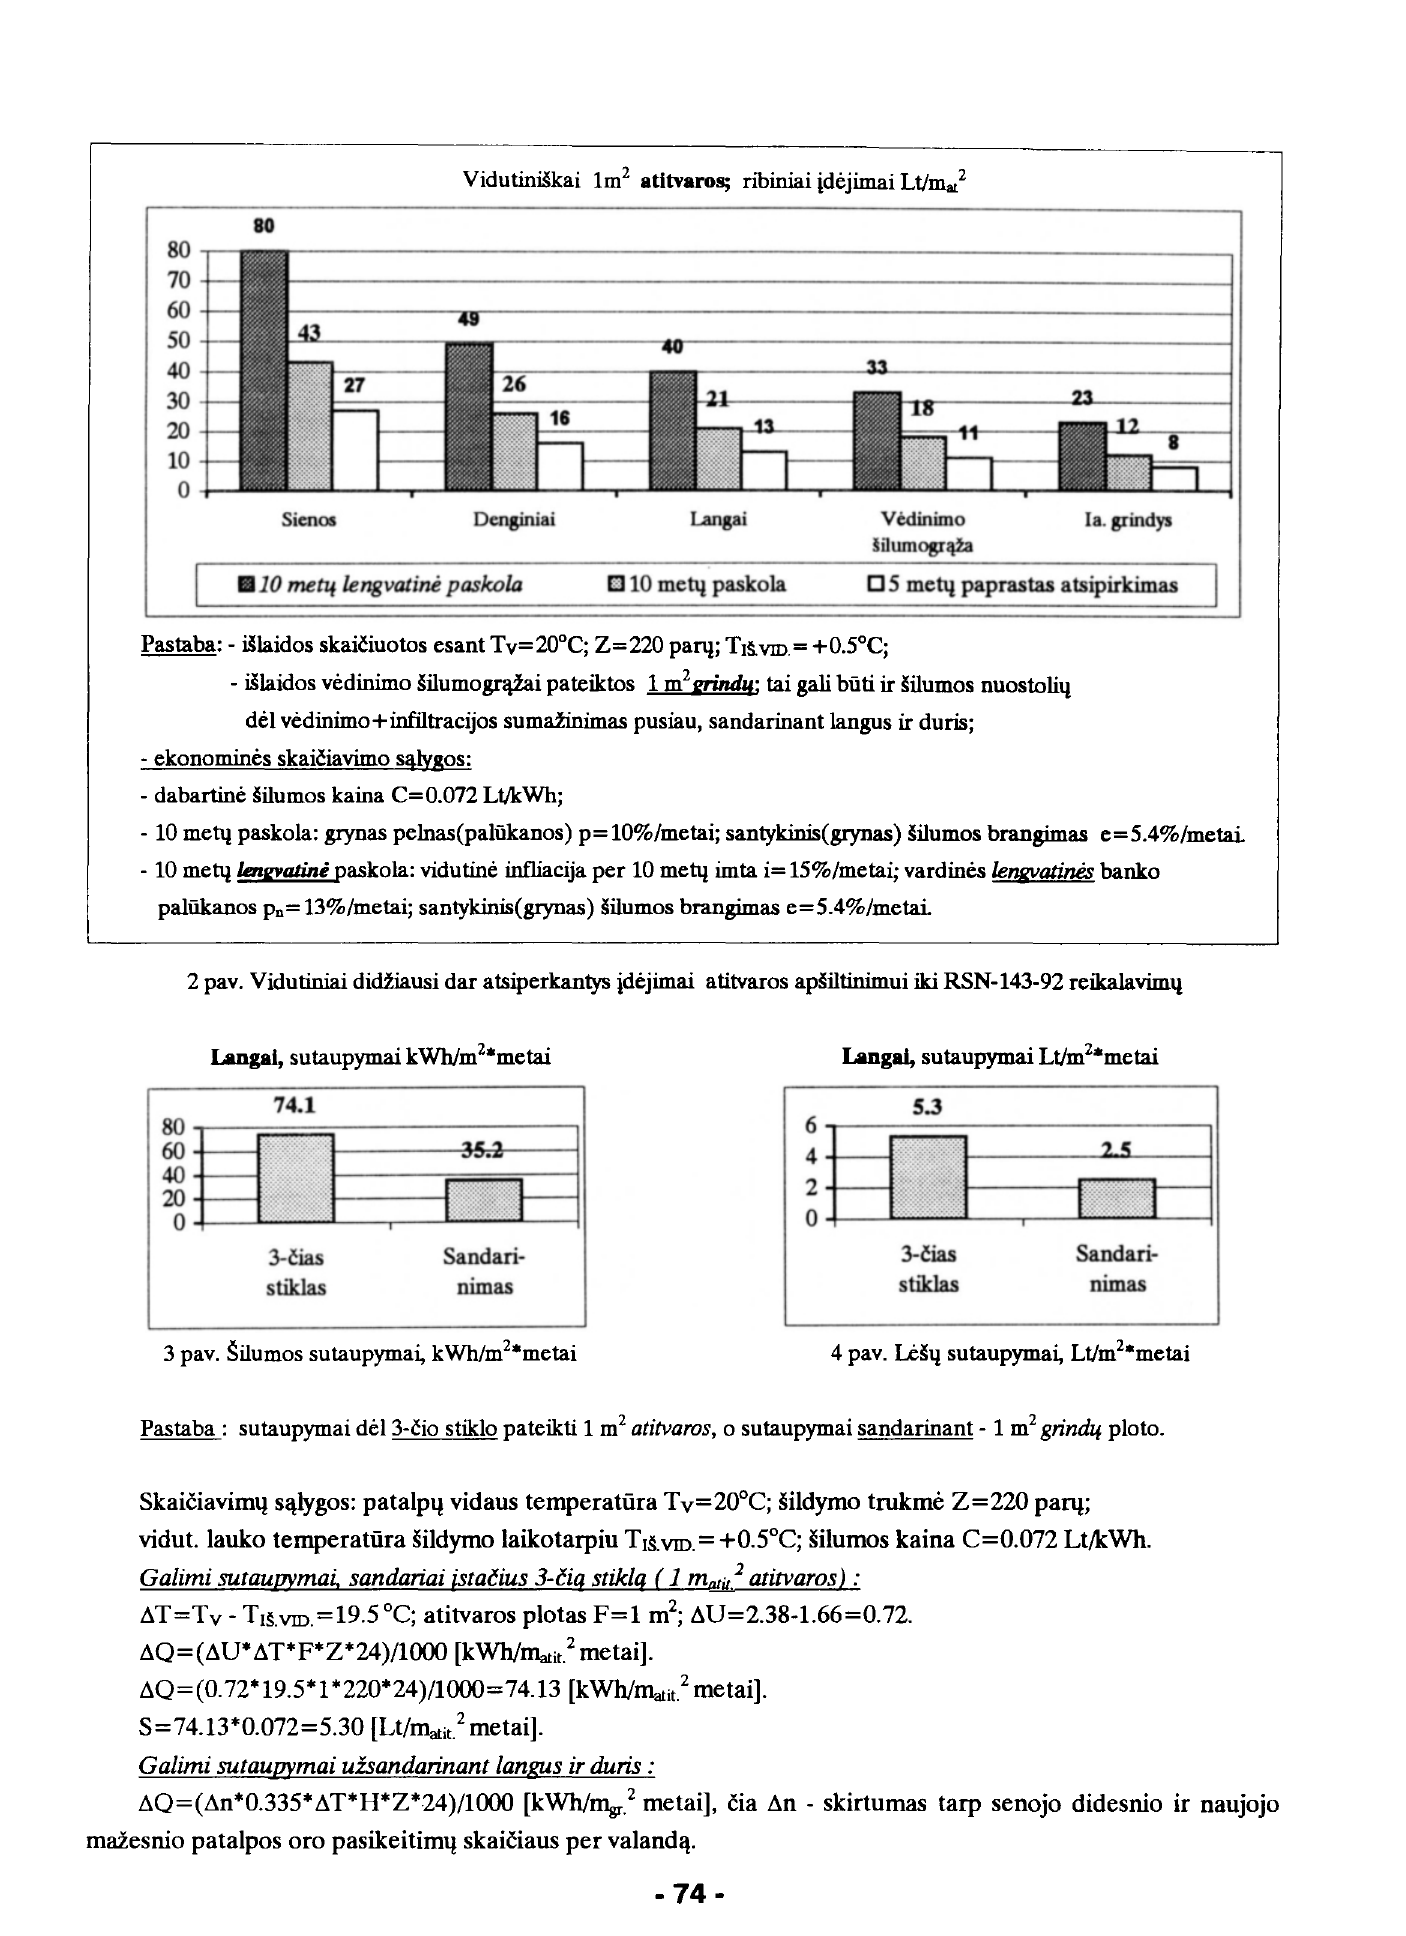
3 pav. Silumos sutaupyma~ kWh/m 2 *metai Pastaba : sutaupymai del3-cio stiklo pateikti 1 m 2 atitvaros, o sutaupymai sandarinant- 1 m 2 grind11 ploto. Skaiciavimq s~lygos: patalpq vidaus temperatura T v=20°C; sildymo trukme Z=220 parq; vidut. lauko temperatura sildymo laikotarpiu TIS.VID. = +O.SOC; silumos kaina C=0.072 LtJkWh. Ga/imi sutauvymai, sandariai istacius 3-ciq stiklq ( 1 ma,u. 2 atitvaros): ~T=Tv- T 1 s.vm.=19.5°C; atitvaros plotas F=1 m 2 ;